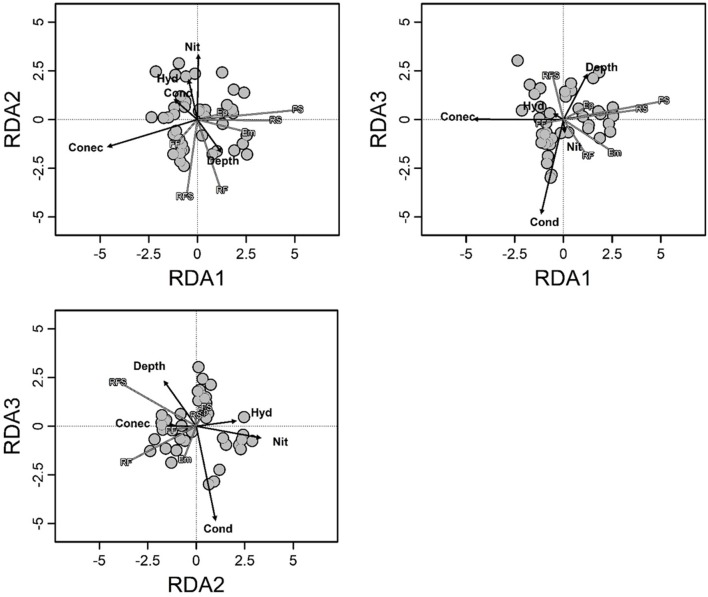
Triplot of redundancy analysis showing the biomass composition of the macrophyte life forms in relation to the environmental variables. Arrows indicate the direction and relative importance of the environmental variables. Hyd, hydrological period; Conec, degree of connectivity; Cond, conductivity; Depth, fourth root of depth; Nit, fourth root of nitrate; Em, emergent; FF, free floating; Ep, epiphytic; RS, rooted submerged; FS, free submerged; RFL, rooted floating-leaved; RFS, rooted floating-stemmed.